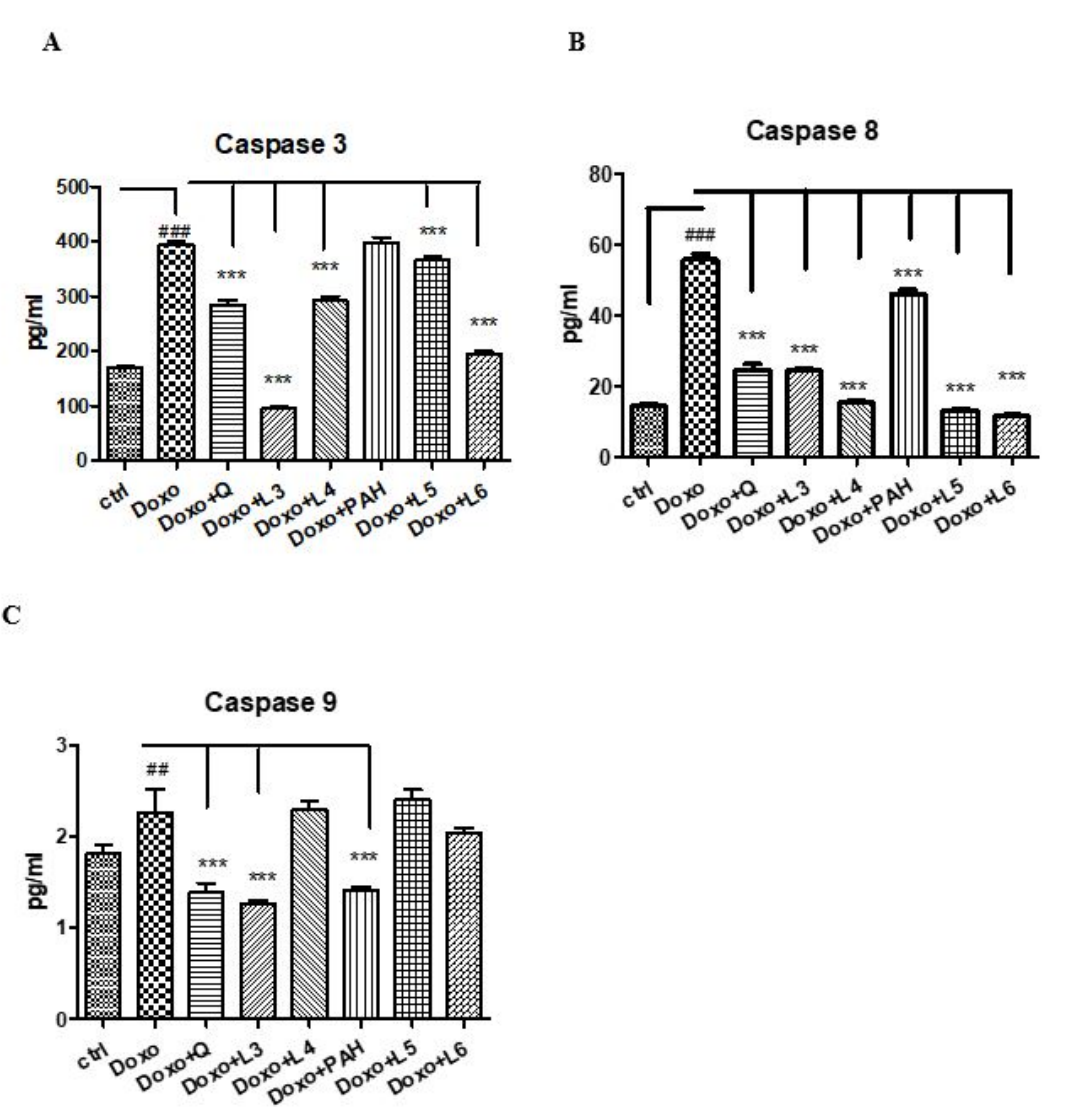
Figure 6. Caspases-3, -8 and -9 in the supernates of HUVECs exposed to Doxo and quercetin, the PAH extract and different liposomes formulations. Caspases-3 ( A ), -8 ( B ) and -9 ( C ) increased significantly after Doxo exposure and diminished both in cells treated with quercetin ( p < 0.001) and L3 ( p < 0.001). The PAH extract significantly reduced caspase-8 and caspase-9 ( p < 0.001), while L5 and L6 decreased the caspase-3 and caspase-8 levels ( p < 0.001). The statistical significance of the difference between the treated and control groups was evaluated with one-way ANOVA, followed by Dunnett’s multiple range test. Data are presented as the mean and SD of triplicate samples. ## p < 0.01; ### p < 0.001 vs. control and *** p < 0.001 vs. Doxo-treated cells.